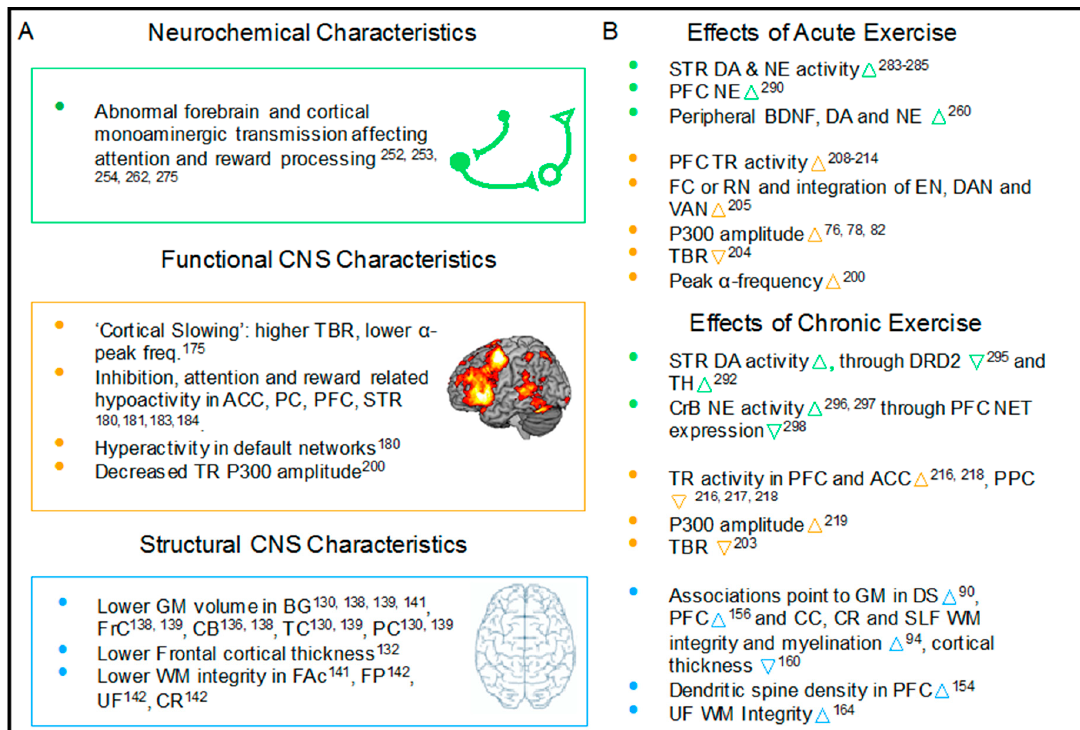
Figure 1. Neurophysiological differences between PBC and children with ADHD and the potential counteractive effects of exercise. ( A ) Identified neurophysiological and anatomical differences between children and adolescent with ADHD and their PBC peers divided into analysis level (‘neurochemical’, ‘functional’ and ‘structural’) in colour-coded boxes. Due to the substantial amount of experimental work conducted on differences in task-related activation between indiviudals with ADHD and PBC peers, the citations all refer to meta-analyses. ( B ) Potential counteracting effects of ‘acute’ and ‘chronic’ exercise are listed in representative colours. Please note that ‘chronic exercise’ encompasses both long-term intervention and associations. Delta and Nabla denote the sign of the physiological change. Abbreviations are listed below. Abbreviations: ACC (anterior cingulate cortex),